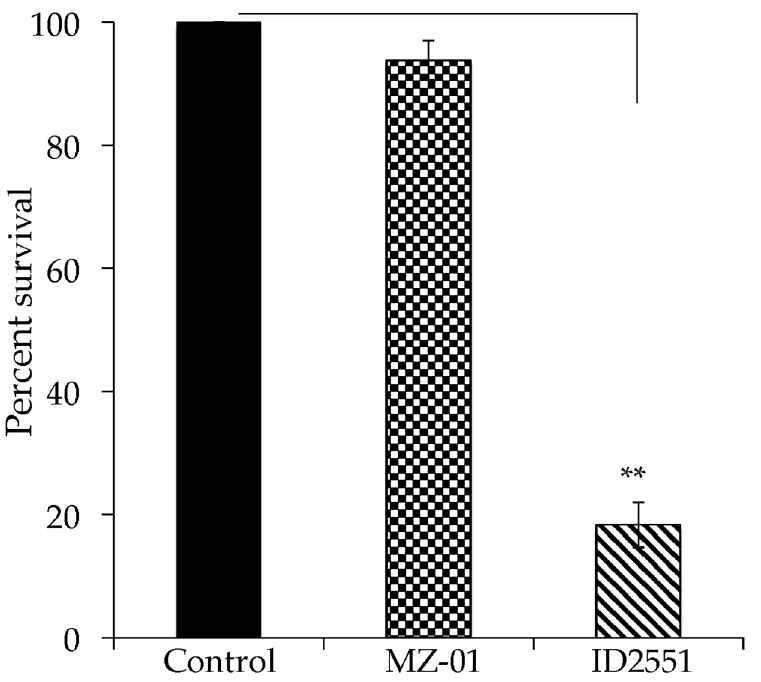
Figure 2. Effect of compounds on cell viability. The monolayer of Vero cells was cultured in RPMI 1640 with 10% FBS and exposed to 400 µ M of compounds in DMSO. Control cells were exposed to DMSO vehicle control. Cell viability was measured after 24 h treatment and is expressed as an average of at least three experiments ± standard deviation. The symbol ‘**’ indicates a significant difference between the control and treated cells ( p <